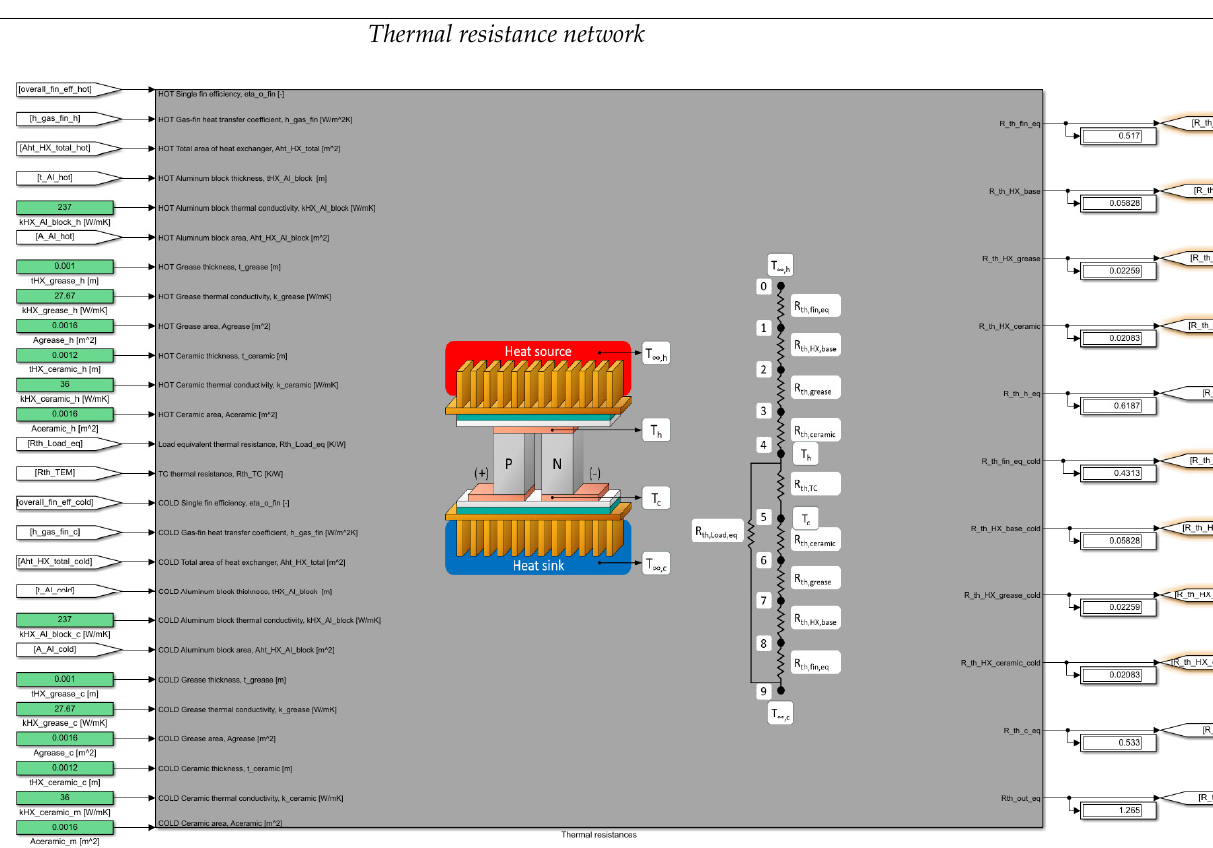
Figure A11. Thermal resistance network